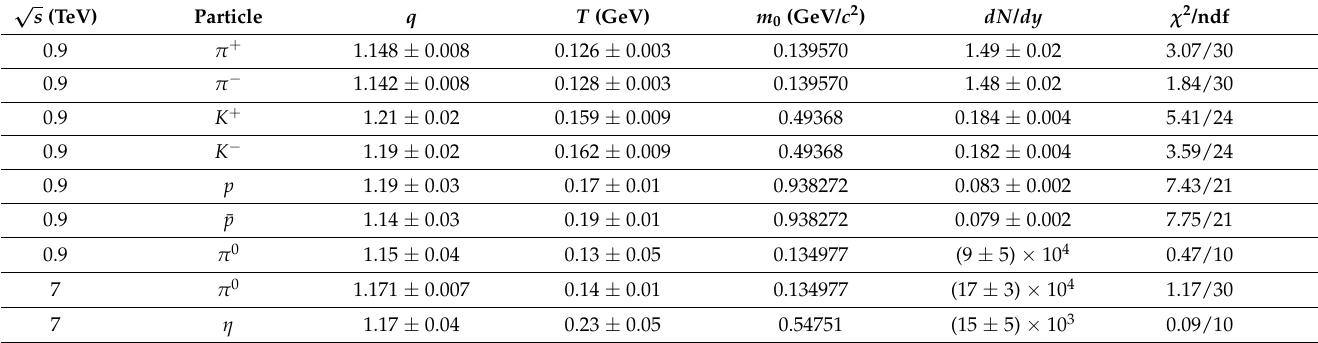
Table 2. Best-fit parameters of the Levy–Tsallis Formula (2). For details, see Table